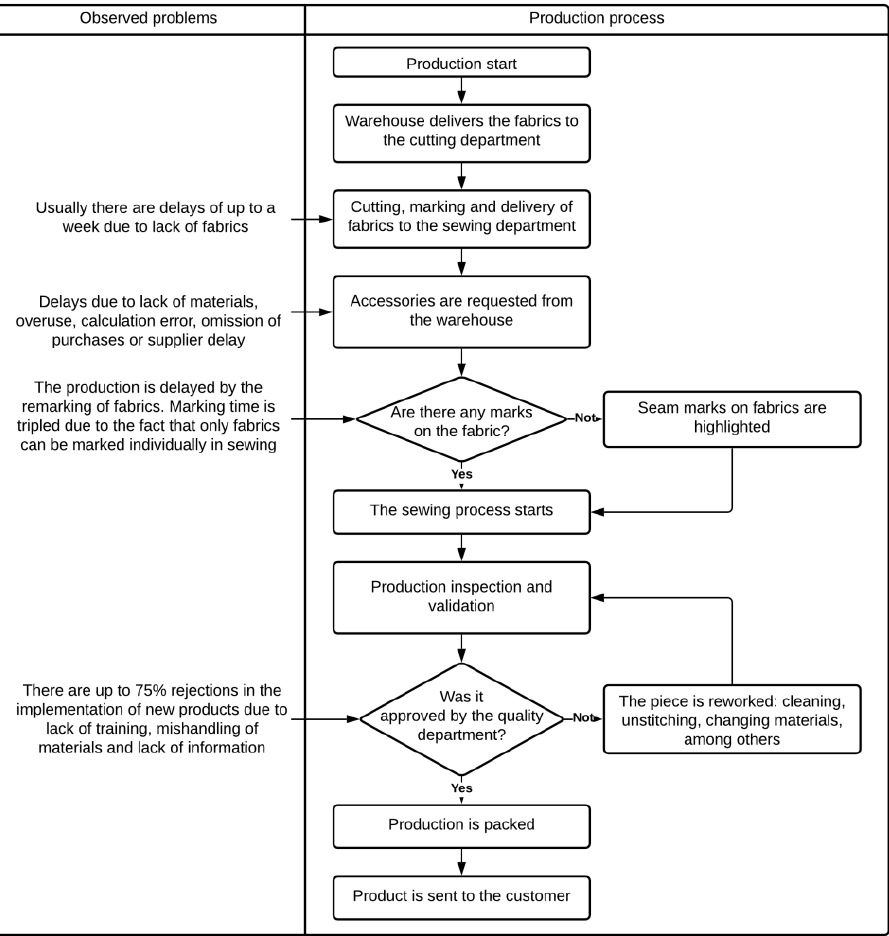
Figure 3. Flow diagram of the production process.